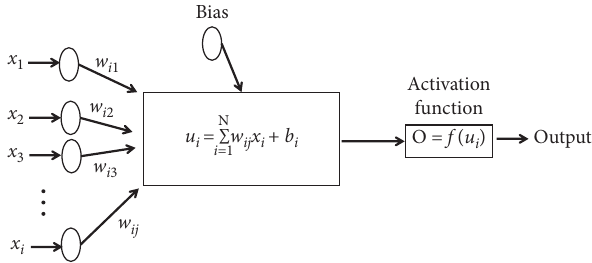
Figure 8: Features in the DNN of the proposed system.